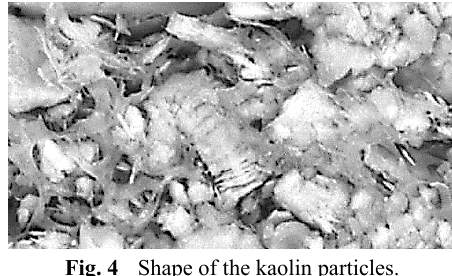
Fig. 4 Shape of the kaolin particles.